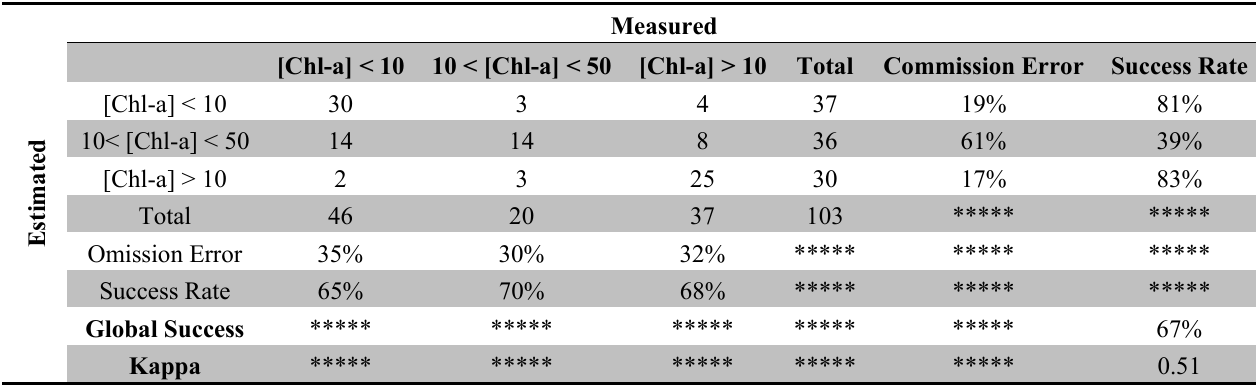
Table 5. The adaptive model confusion matrix results.